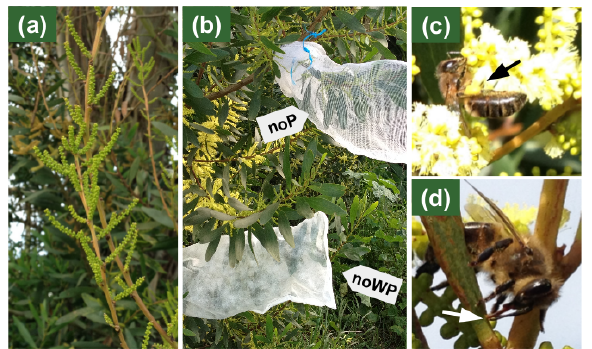
Figure 1. (a) Inflorescence at the green-button stage, as selected for the exclusion experiments; (b) mesh net positioned on the branch, of larger texture for exclusion of pollinators (noP) and allowing wind and of finer texture for exclusion of wind and pollinators (noWP); (c) Portuguese honeybee collecting pollen on A. longifolia inflores- cence; black arrow indicates pollen on the corbiculae, identifying the individual as a pollen forager; (d) Portuguese honeybee collect- ing nectar from an extrafloral nectary (exact position indicated by the white